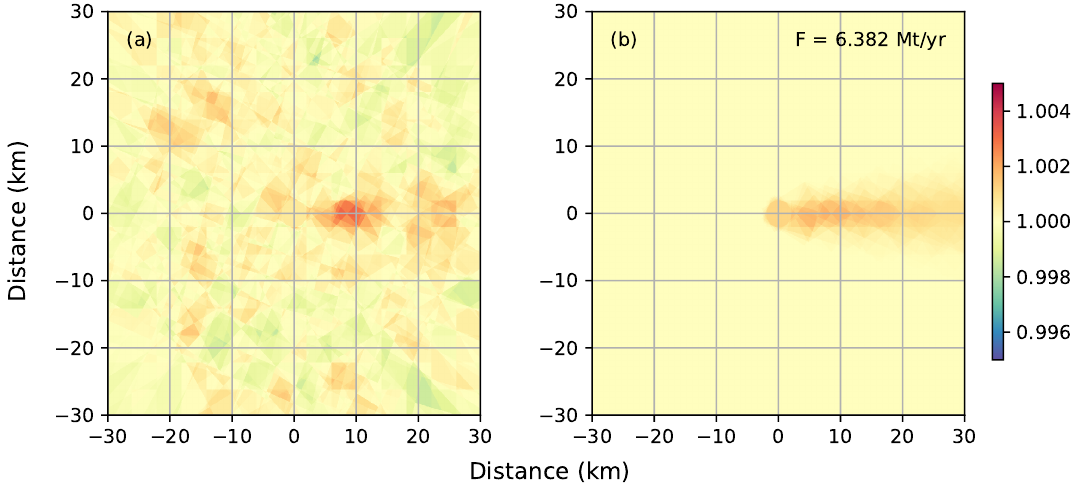
Figure 12. XCO 2 observations relative to a 400 ppm background for one instance of the 30 member ensemble for a 6 Mt yr − 1 source. ( a ) Average observations from 6 simulated images at varying wind directions. ( b ) Fitted relative XCO 2 enhancements from the least squares fit. The label identifies that the estimated emission rate was 6.382 Mt yr − 1 for this ensemble